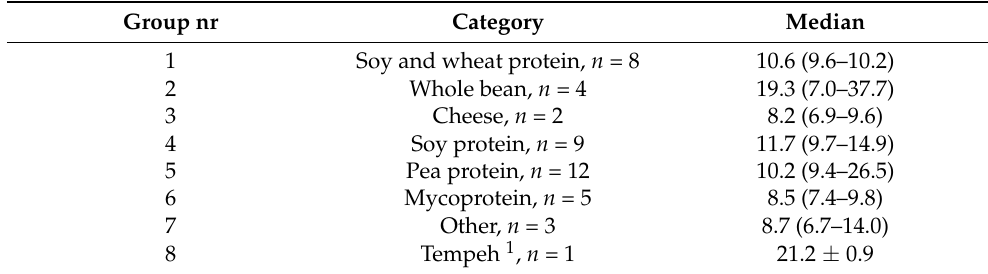
Table 2. Total phenolic content in the analyzed meat substitutes separated and analyzed according to protein source. Data are presented as median value (25th percentile–75th percentile) and are shown as mg gallic acid equivalents (GAE) per 100 g product. 1 Results on tempeh are shown as average mg GAE/100 g product ± standard deviation since the sample size was limited to